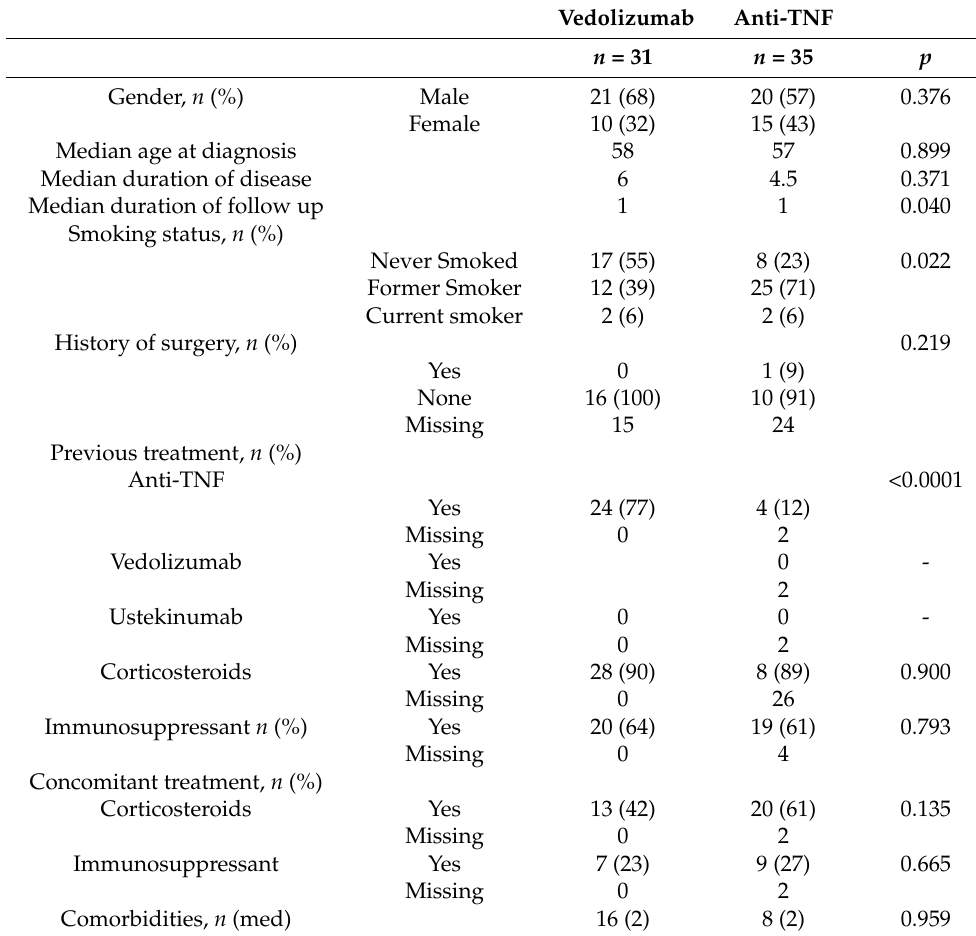
Table 2. Comparison of baseline characteristics for patients with ulcerative colitis according to